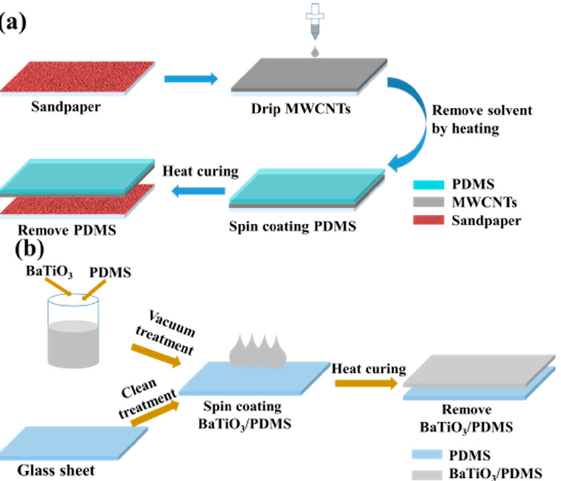
Figure 1. Fabrication process of the sensor. Fabrication process of the ( a ) microstructured electrode and ( b ) BaTiO 3 /PDMS dielectric layer.